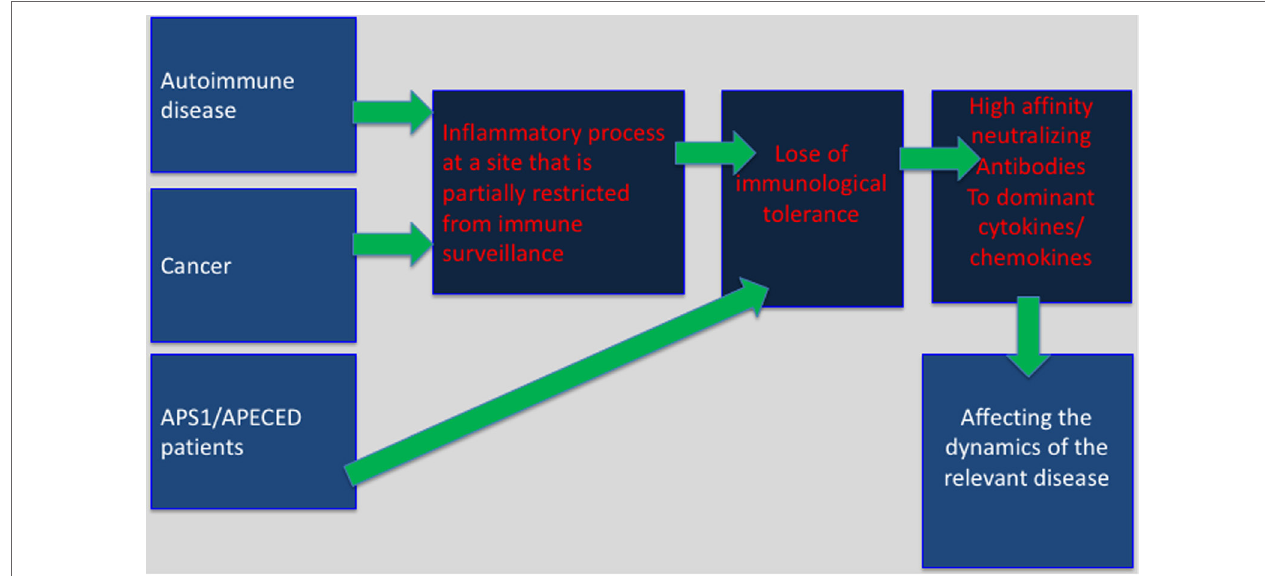
FiGURe 1 | Selective breakdown of B cell tolerance to key inflammatory cytokines/chemokines regulates cancer, autoimmunity and infectious diseases: selective breakdown of tolerance to chemokines and cytokines may result from the generation of an inflammatory process at sites that are partially restricted from immune surveillance (autoimmune sites, tumor sites) or as a results of a deficiency in central tolerance (APS1/APECES patients with autoimmune regulator deficiency). In both, it is believed that breakdown of B cell tolerance follows the breakdown of T cell tolerance. The data obtained from APS1/APECES patients strongly support this